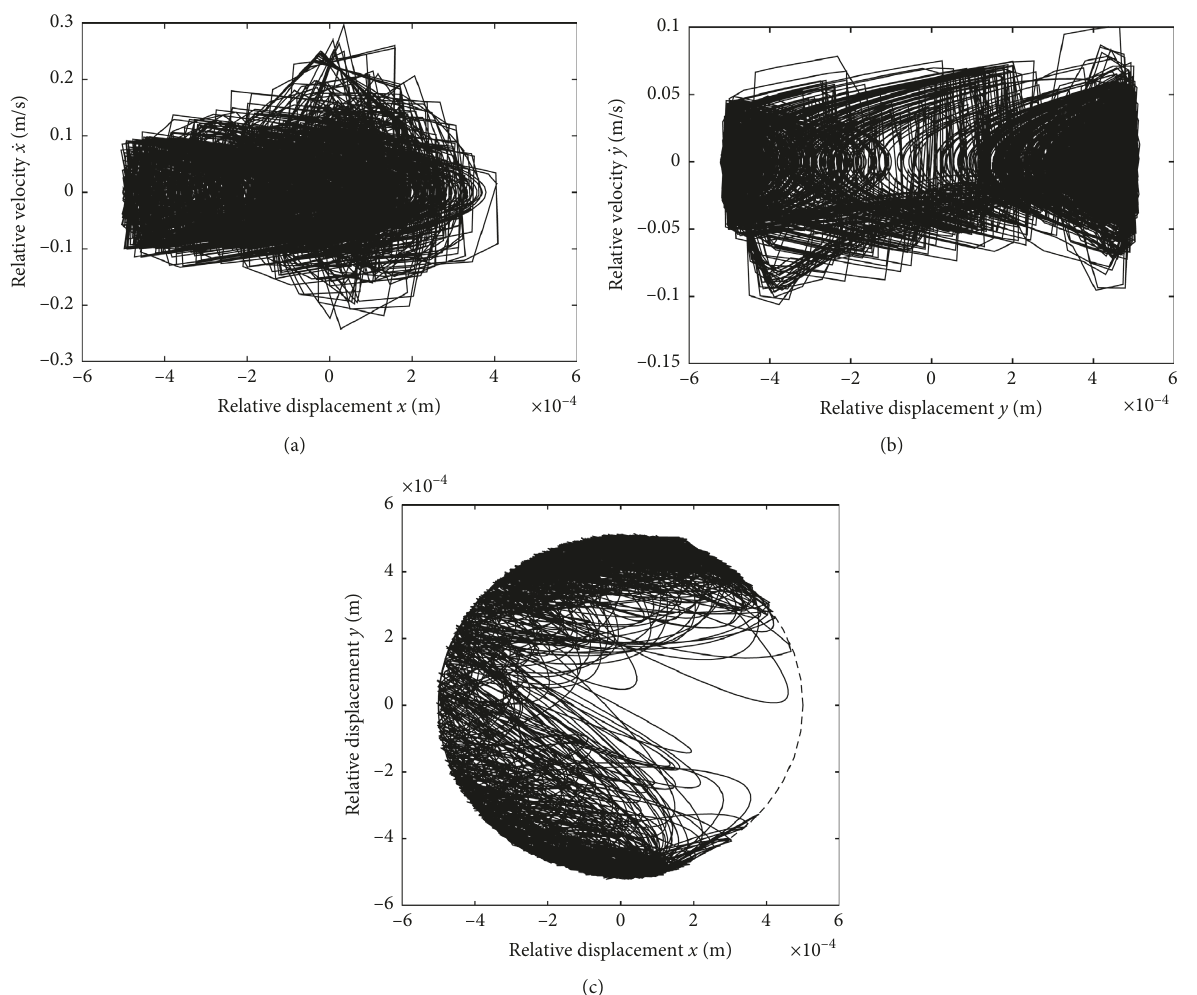
Figure 8: Phase diagram of 2-DOF nine-bar mechanism: (a) relative displacement and relative velocity in x direction; (b) relative dis- placement and relative velocity in y direction; (c) relative displacement in x and y